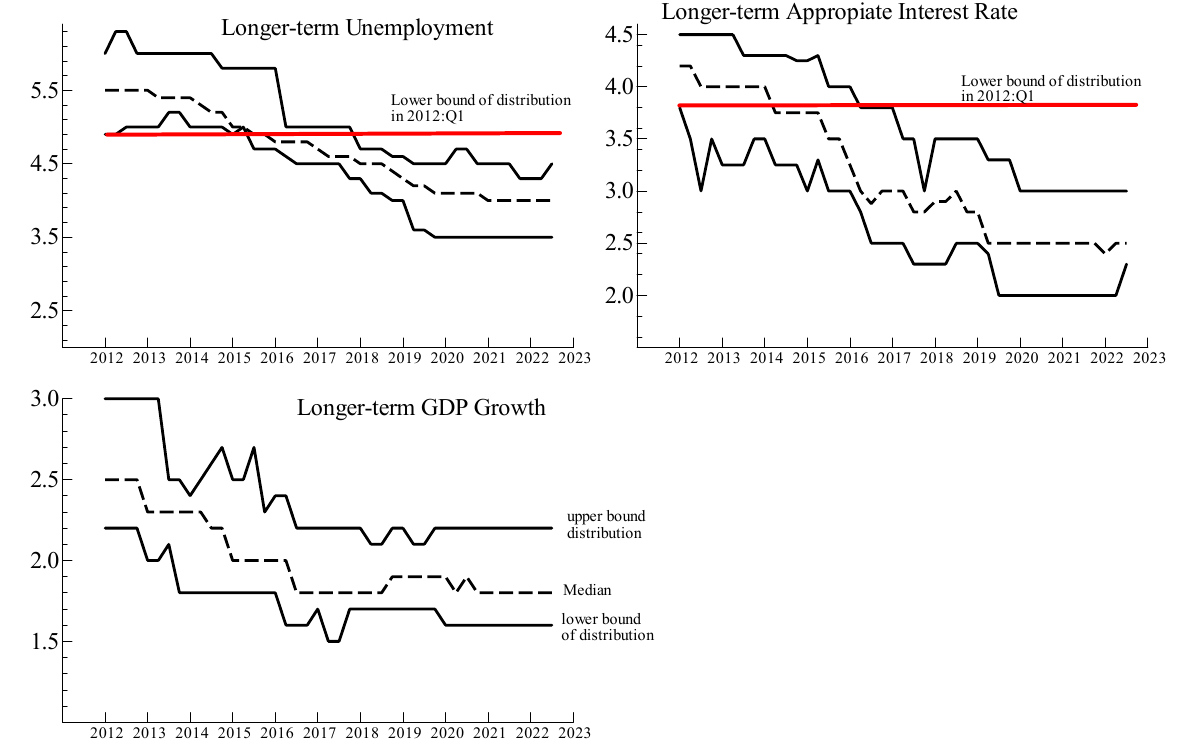
Figure 8. Evolution of the distributions of the FOMC’s longer-run forecasts. Solid lines in each panel are the bounds of the distribution of the associated variable; the dashed lines are the median of the respective distributions.